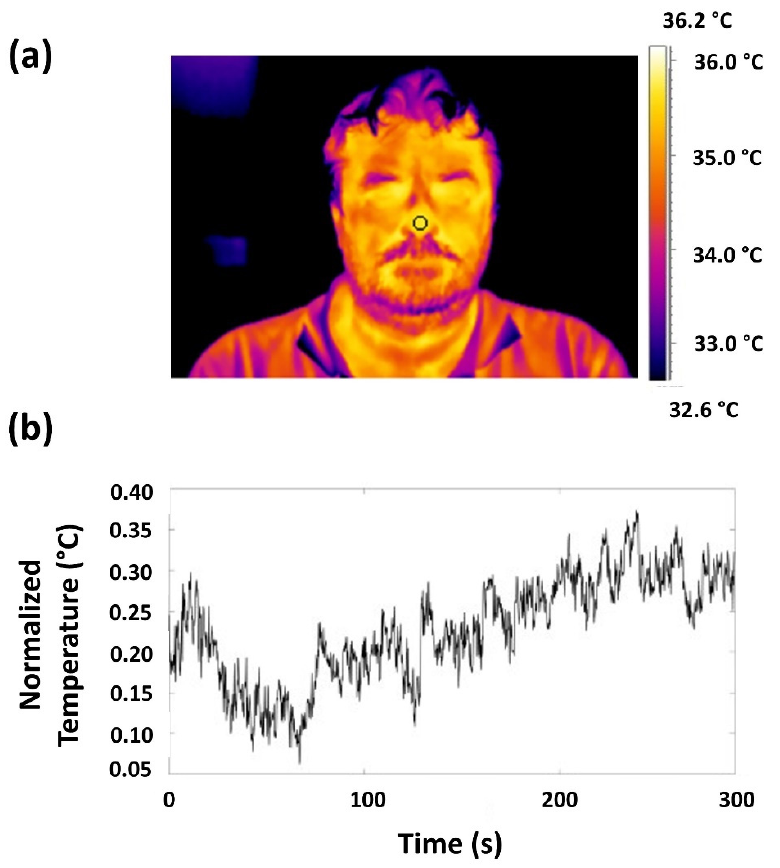
Figure 1. ( a ) Thermogram of a representative participant and ROI placement over the nose tip; ( b ) temperature oscillations over the selected ROI.